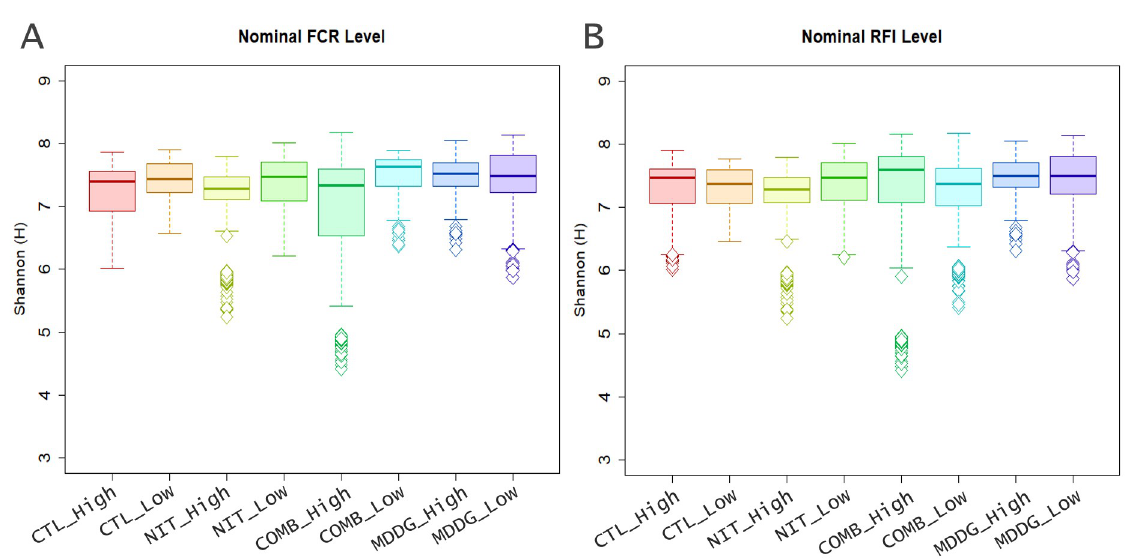
Fig 3. Differences in diversity using the Shannon index